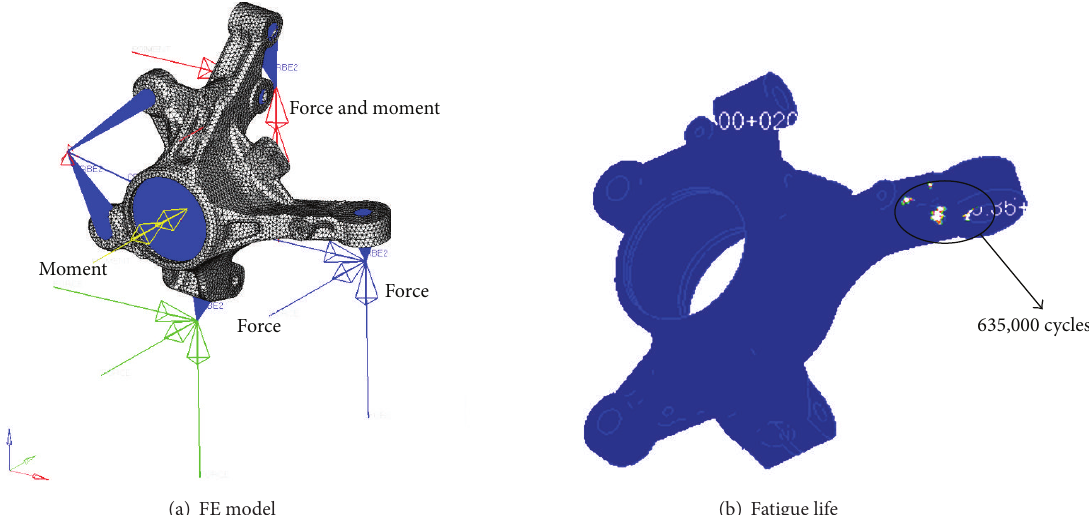
Figure 6: FE analysis for durability analysis of nonbraking condition.